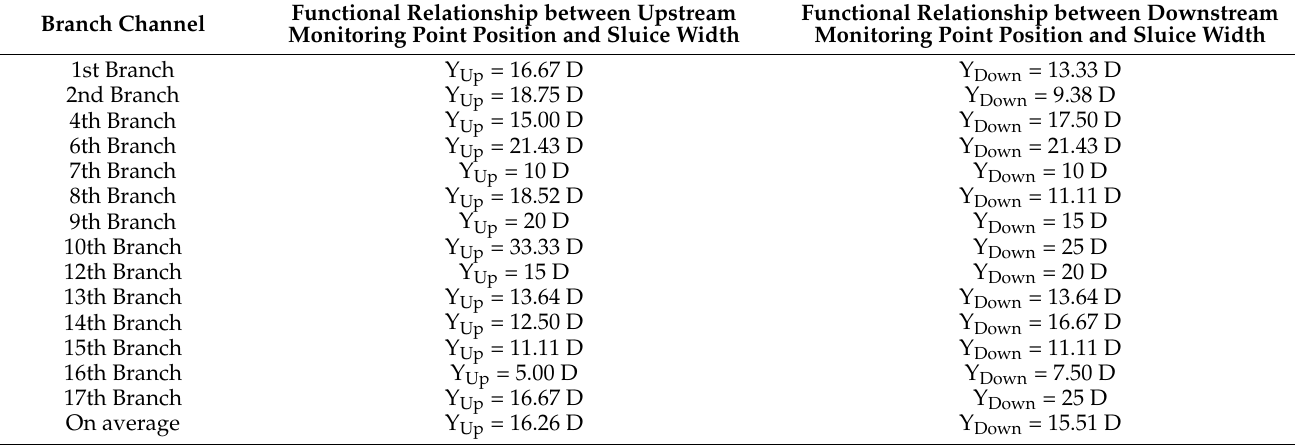
Table 4. The functional relationship between the positions of the upstream and downstream monitoring points and the width of the sluice. Note: Y Up is the distance between the upstream monitoring point and the gate; Y Down is the distance between the downstream monitoring point and the sluice; D is the width of the sluice. Branch